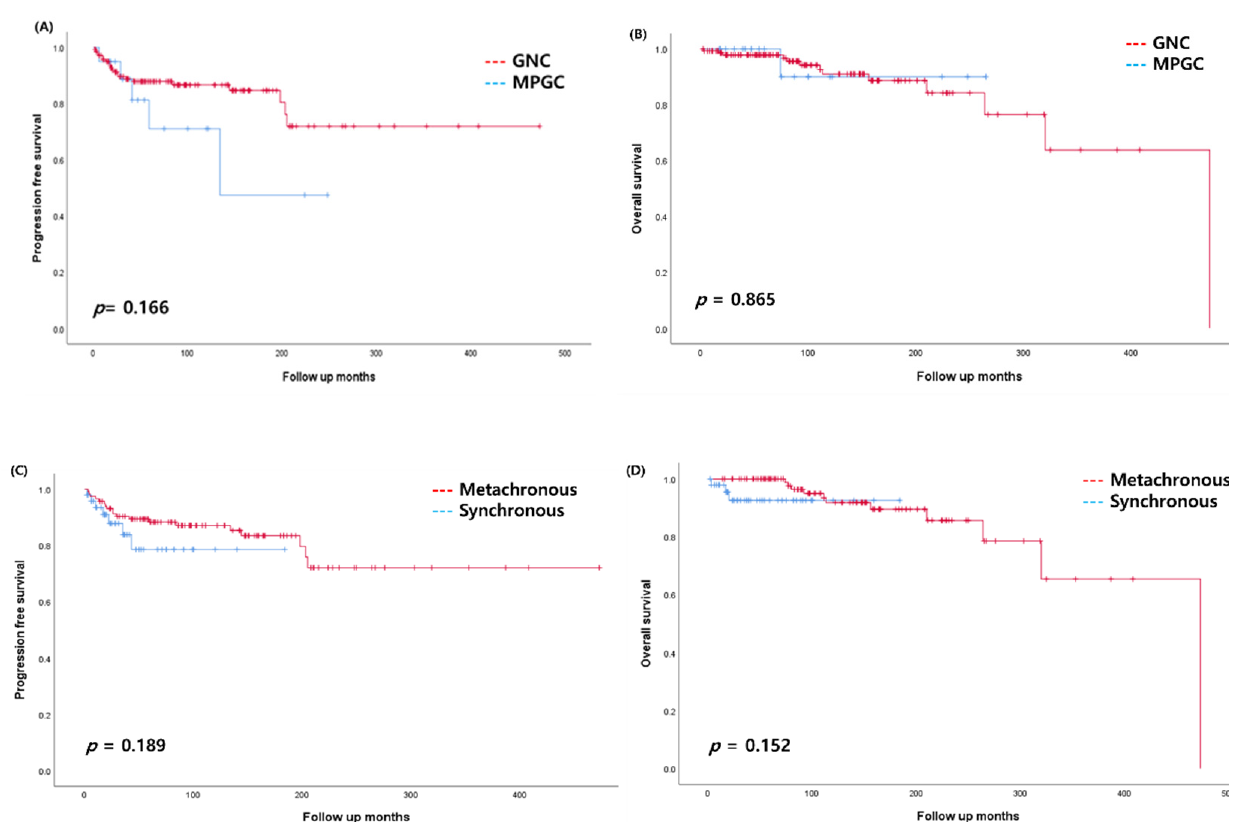
Figure 3. Progression-free survival (PFS) and overall survival (OS) of patients with multiple primary malignant tumors (MPMT) with gynecologic cancer. Comparisons of ( A ) PFS and ( B ) OS between patients with multiple primary gynecologic cancer (MPGC) and gynecologic cancer coexisting with non-gynecologic cancer (GNC). Comparison of ( C ) PFS and ( D ) OS between patients with synchronous and metachronous malignancies. Table 1. Comparison of patient characteristics between non-gynecologic cancer (GNC) and multiple primary gynecologic cancers (MPGC).